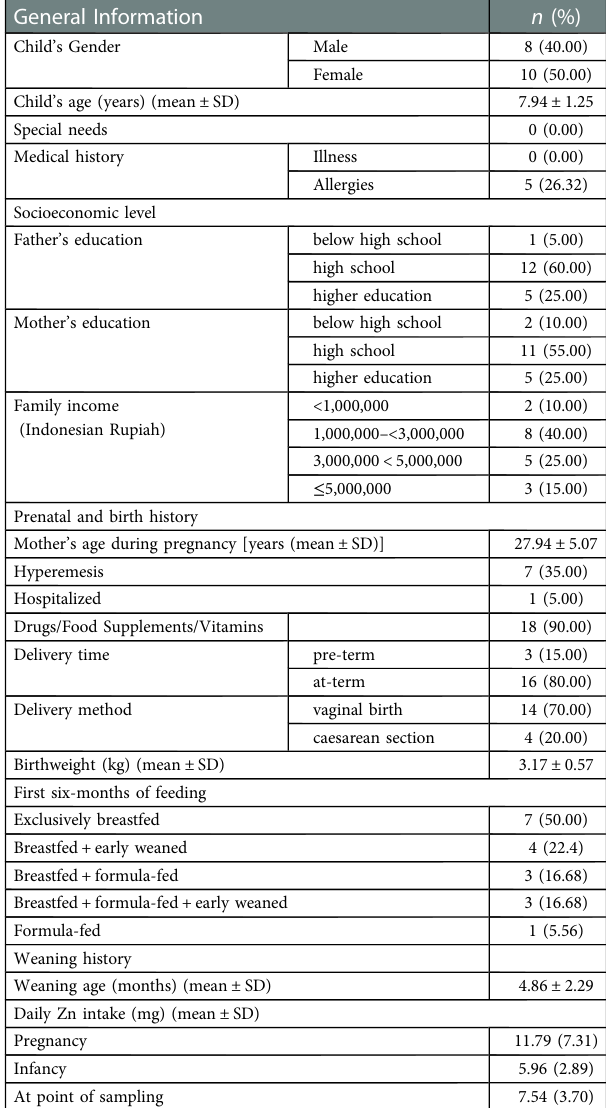
TABLE 2 Characteristics of the study participants ( n